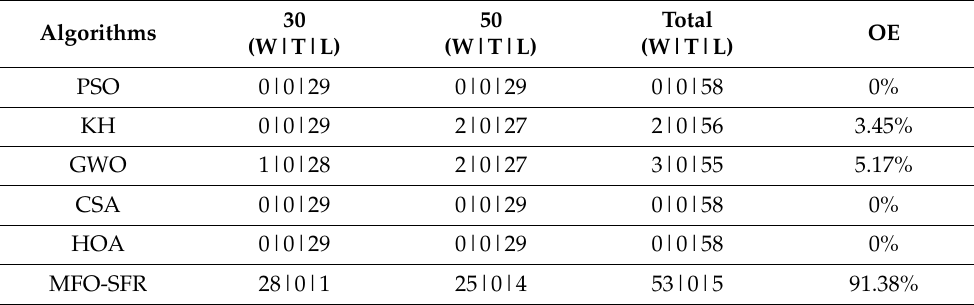
Table 8. The overall effectiveness of MFO-SFR and contender algorithms.